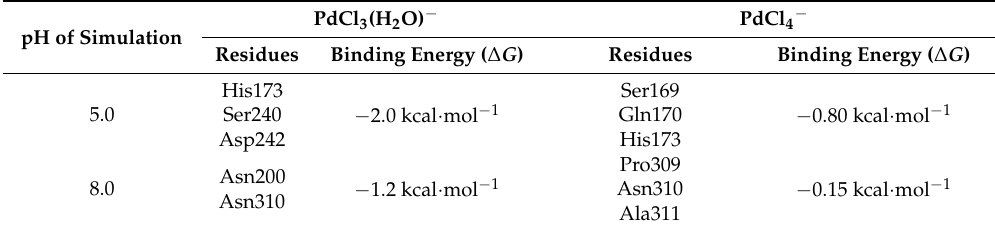
Table 1. Molecular docking VP6 trimer with Pd(II) ions. Datasets obtained from the